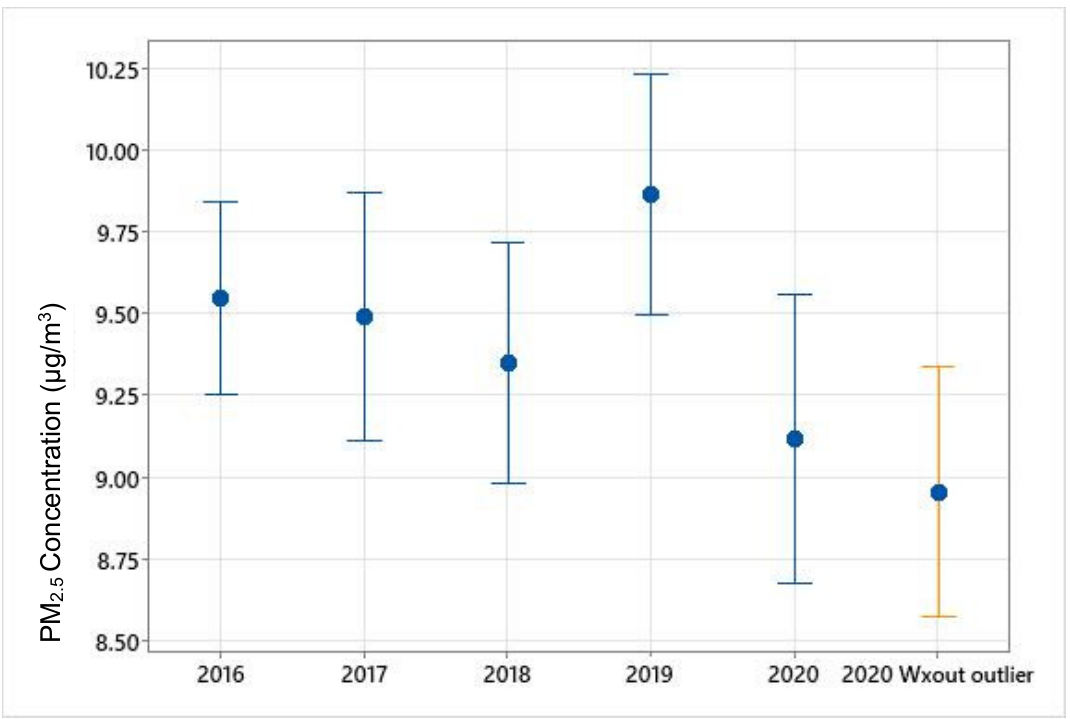
Figure 5. Yearly mean PM 2.5 concentrations from 2016 to 2020. Error bars represent 95% confidence interval of the mean.